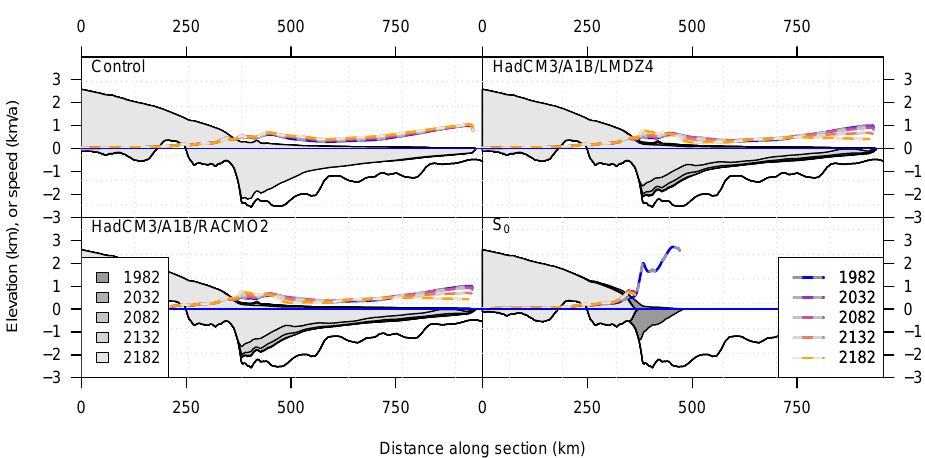
Figure 6. Cross-section plots of ice sheet geometry and velocity. The cross section follows Lambert Glacier onto the ice shelf, and on to the calving front and is shown in Figs. 1 and 8. Simulation year is indicated by a greyscale for then geometry, and colours for the speed. The ice shelf remains stable in the control run, and thins in all the FESOM-forced runs. The HadCM3/A1B/LMDZ4 simulation shows the same pattern of thinning and velocity change over 200 years as the HadCM3/A1B/RACMO2 simulation, despite the factor of 4 difference in accumulation anomalies (see Table 1).